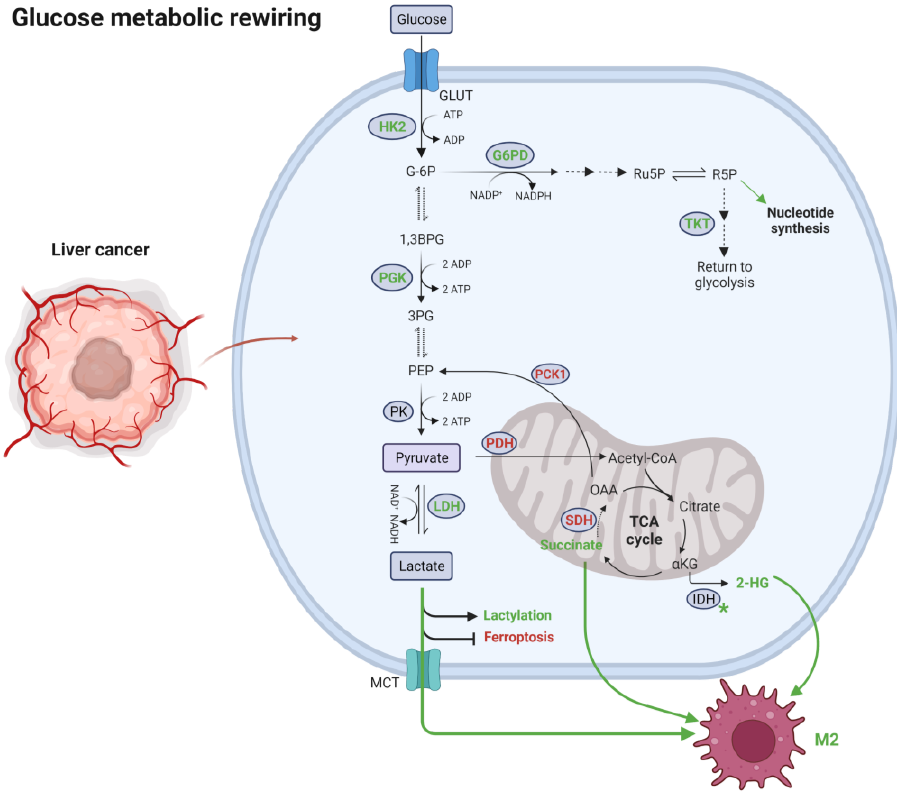
Figure 1. Metabolic rewiring of glucose in liver cancer cells and effects on immune cells infiltration. As illustrated in the review text, deregulation of glucose affects the recruitment and/or the activation of immune cells, potentially favoring immune escape of liver cancer cells. Abbreviations: 1,3BPG, 1,3- Bisphosphoglycerate; 2-HG, 2-hydroxyglutarate; 3PG, 3-Phosphoglycerate; G6P, glucose 6-phosphate; G6PD, glucose-6-phosphate dehydrogenase; GLUT, glucose transporter type; HK2, hexokinase 2; IDH, isocitrate dehydrogenase; LDH, lactate dehydrogenase; M2, M2 macrophage; MCT, monocarboxylate transporter; OAA, oxaloacetate; PCK1, phosphoenolpyruvate carboxykinase 1; PDH, pyruvate dehydrogenase; PEP, phosphoenolpyruvate; PK, pyruvate kinase; R5P, ribose 5-phosphate; Ru5P, ribulose 5-phosphate; SDH, succinate dehydrogenase; TKT, transketolase; α KG, α -ketoglutarate. Legend: green arrows and green bold text indicate up-regulated pathways; red arrows and red bold text indicate down-regulated pathways; * indicate mutations. Created with